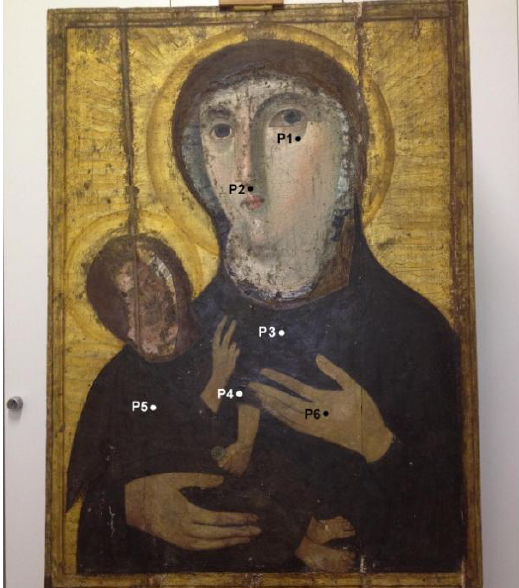
Figure 5. Icon and a few selected regions among those measured by unilateral